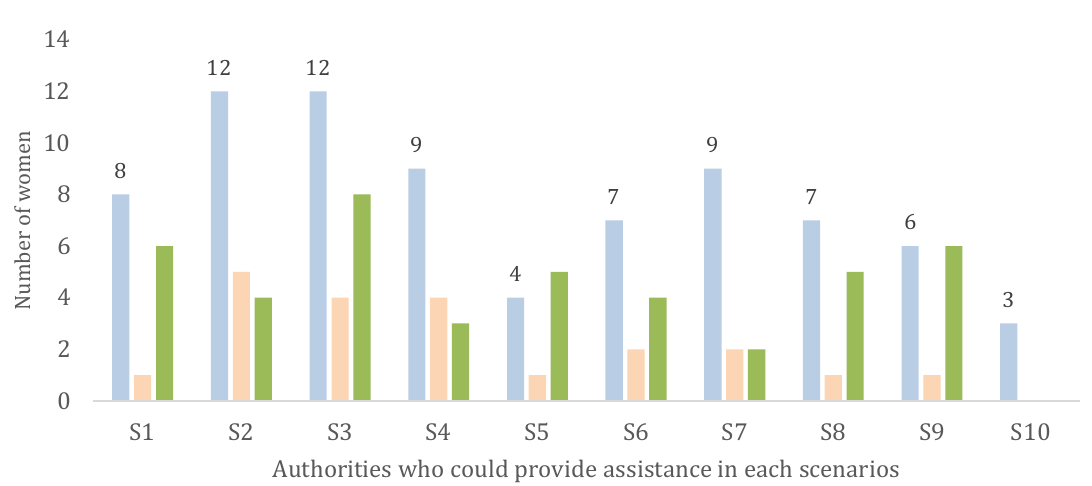
Figure 1: Frequency of women seeking help from different